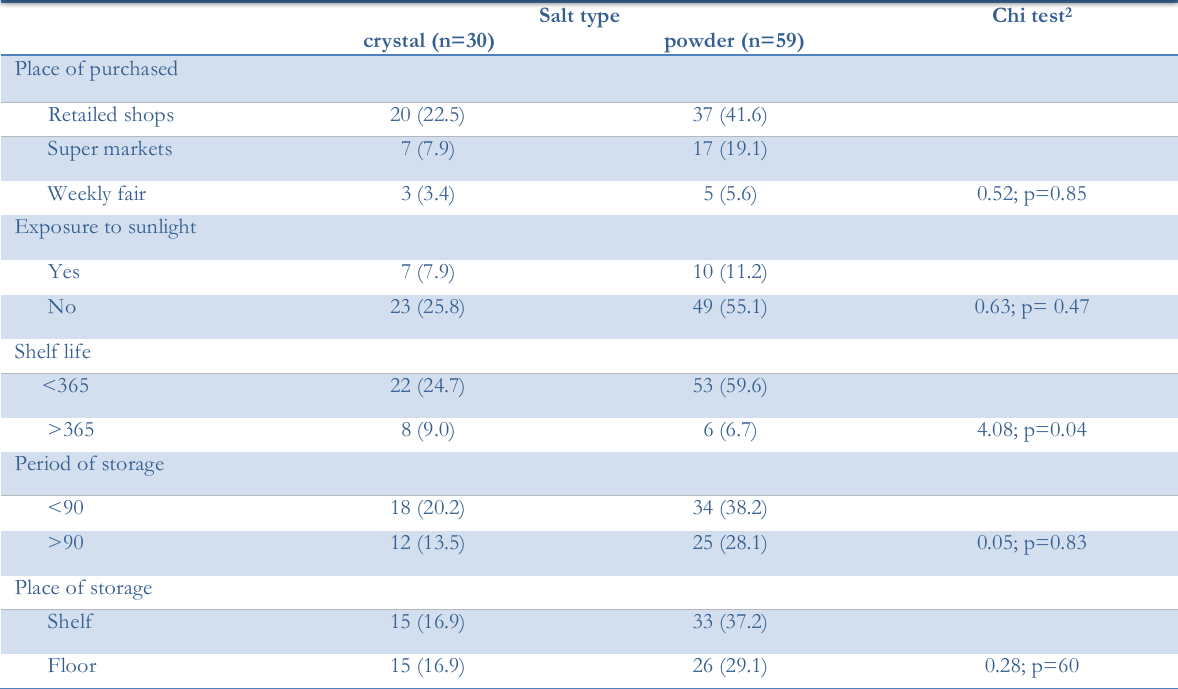
Table 1: Characteristics of salt usage & the type